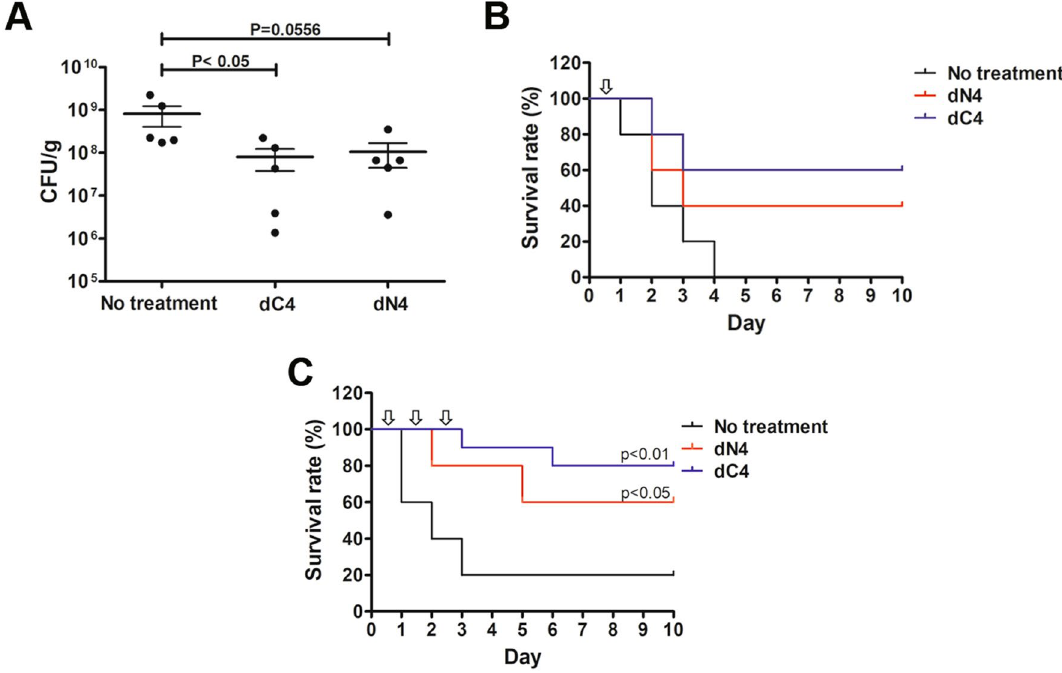
Figure 3. Intravascular administration of dN4 and dC4 reduced bacteria numbers in lung tissue and reduced mortality associated with A. baumannii- induced pneumonia. ( A ) Mice were intratracheally infected with A. baumannii ATCC 17,978 at a dose of 5 × 10 8 CFU. dC4 or dN4 (2 mg/kg) was intravascularly administrated 4 h after bacterial infection. Infected mice were sacrificed 1 d after infection, and lung tissue was isolated. Bacteria that colonized lung tissue were quantified by plating on LB agar plates. Each point represents one mouse. Data represent means ± standard error of the means and were statistically analyzed using Mann–Whitney U-test versus the no treatment group. ( B ) Mice were intratracheally infected with A. baumannii ATCC 17,978 at a dose of 5 × 10 8 CFU. dC4 or dN4 (2 mg/kg) was intravascularly administrated 4 h after bacterial infection. Mouse survival was detected daily ( n = 5/group). ( C ) Mice were intratracheally infected with A. baumannii ATCC 17,978 at a dose of 5 × 10 8 CFU. dC4 or dN4 (2 mg/kg) was intravascularly administered once a day for 3 d. Mouse survival was detected daily ( n =